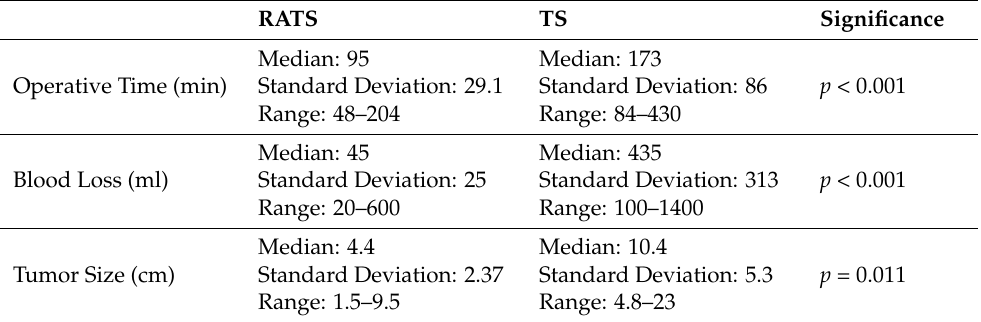
Table 2. Operative data.